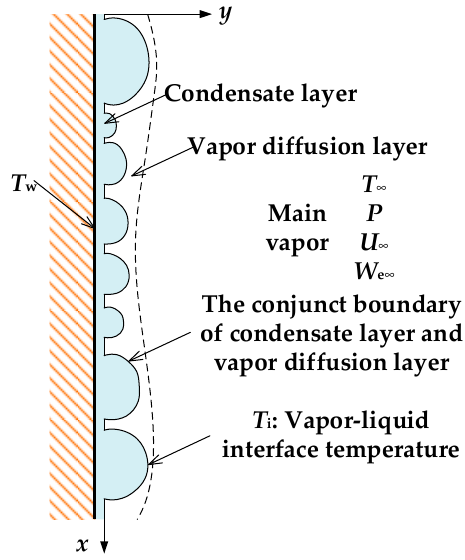
Figure 1. Schematic diagram of Marangoni condensation.